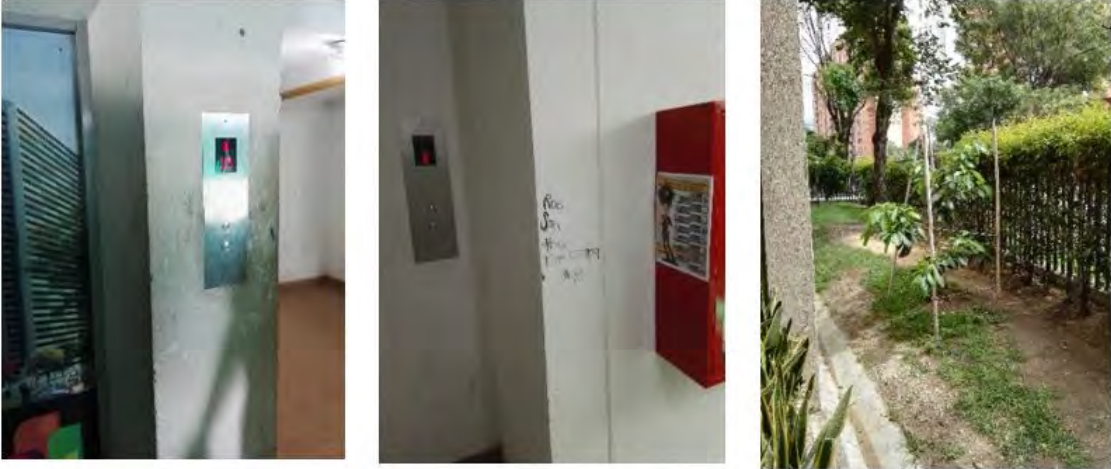
Figure 6. Conservation of quality in